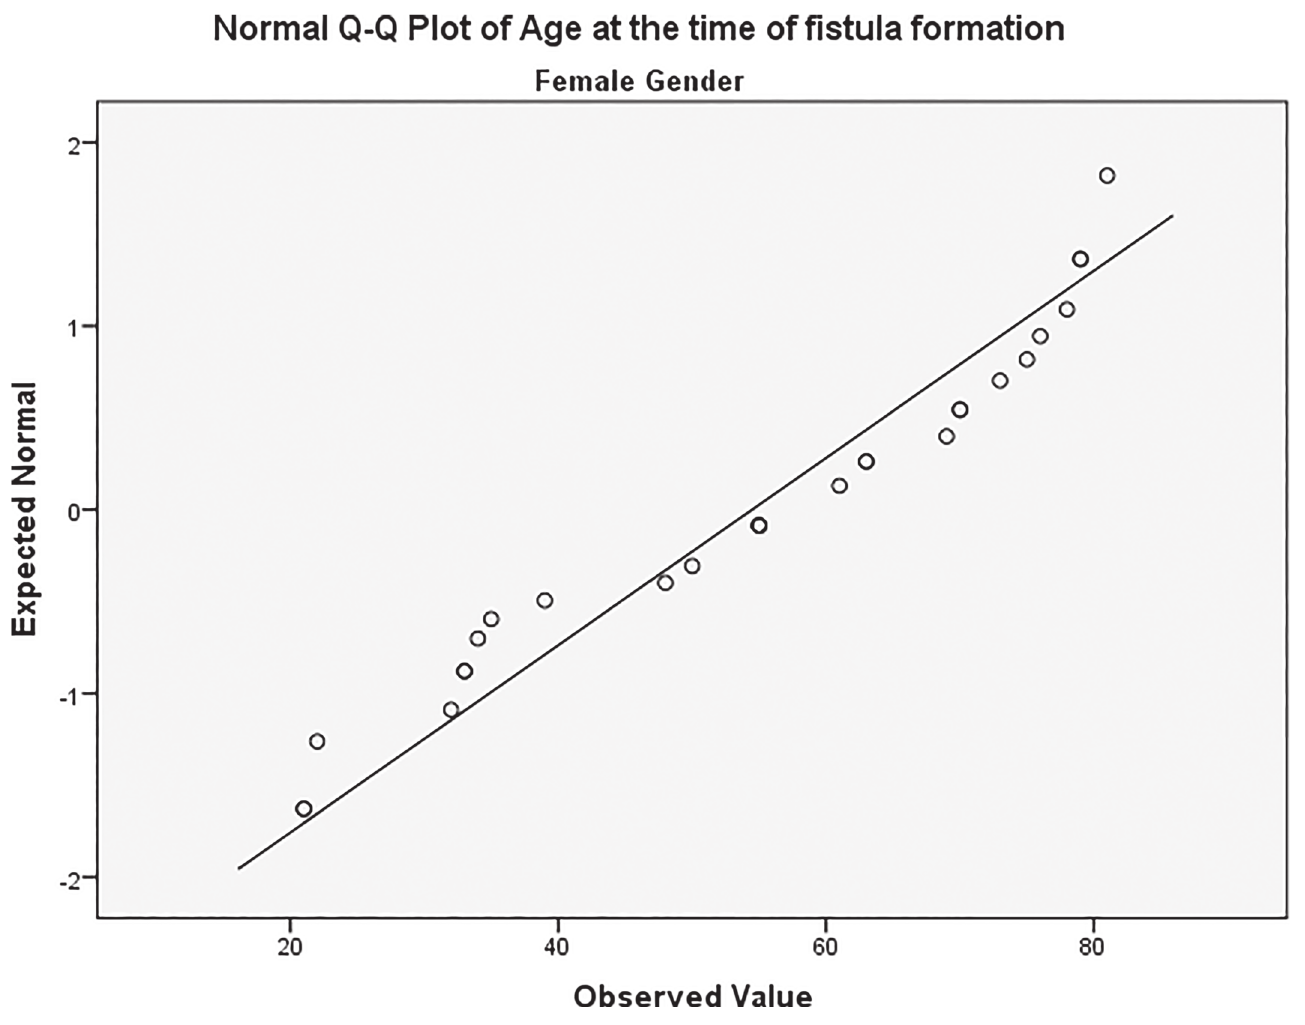
Fig 2. Age distribution among female